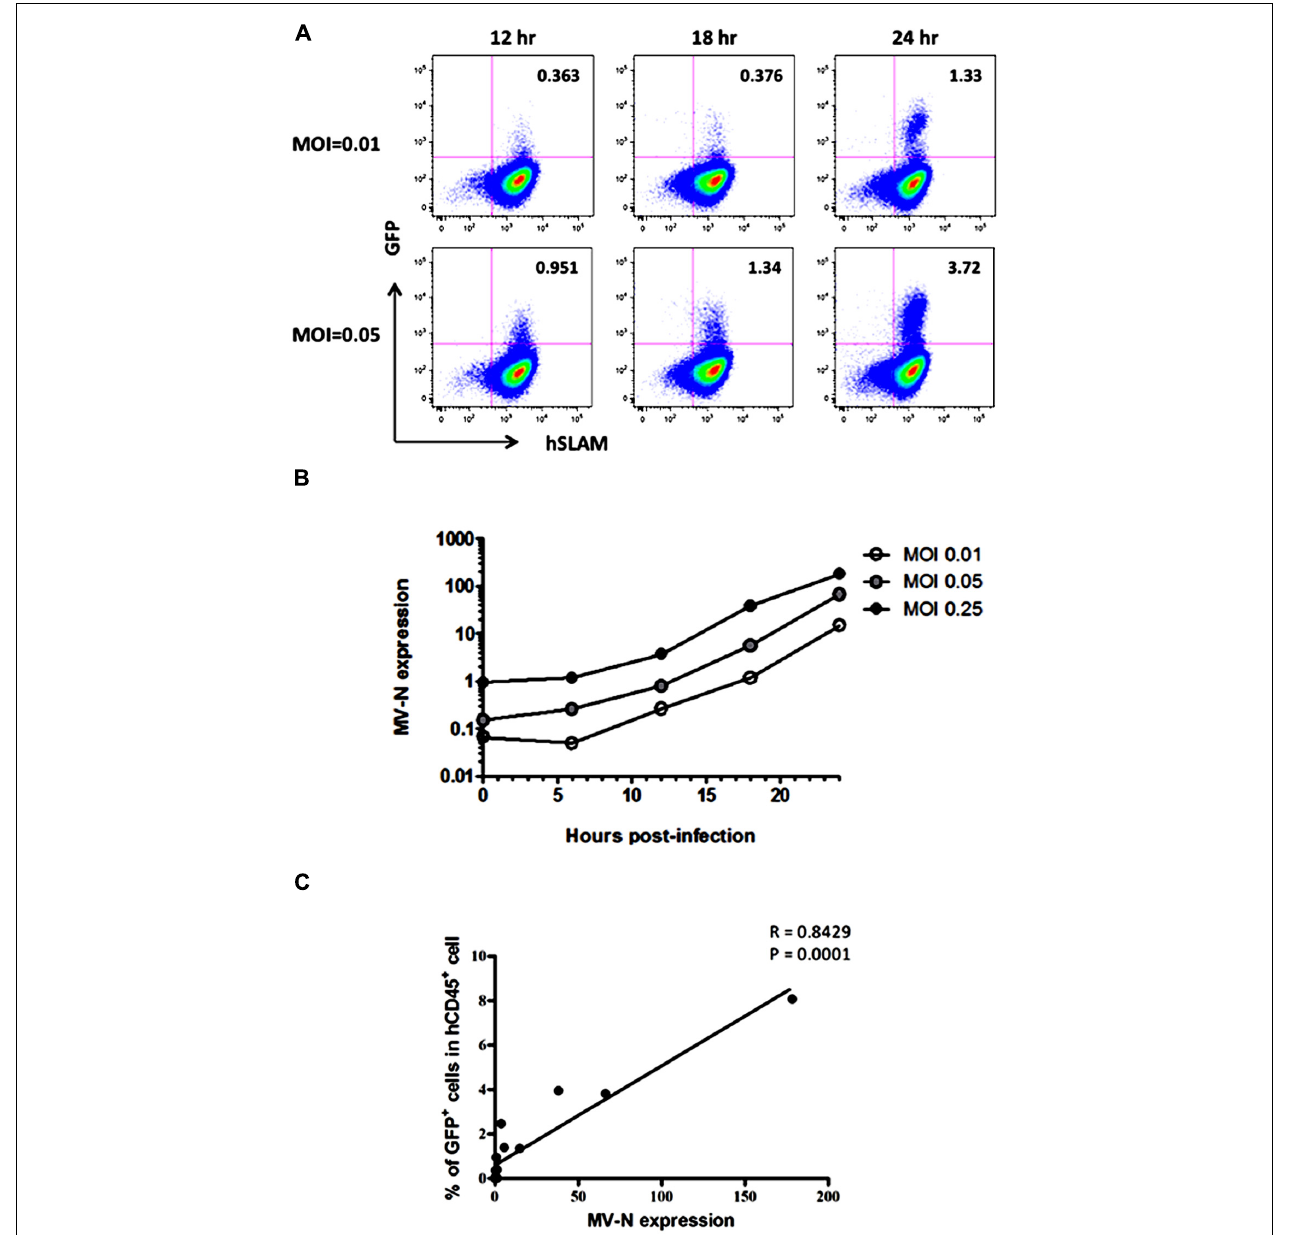
P were analyzed by one-step qRT-PCR. The copy numbers of MV-N and RNase P were determined, and the ratio of MV-N copies to RNase P copies is depicted on the vertical axis. (C) Correlation between the percentage of GFP + Jurkat/SLAM cells and the time course of MV-N expression. Spearman’s rank correlation coefficient was used for statistical